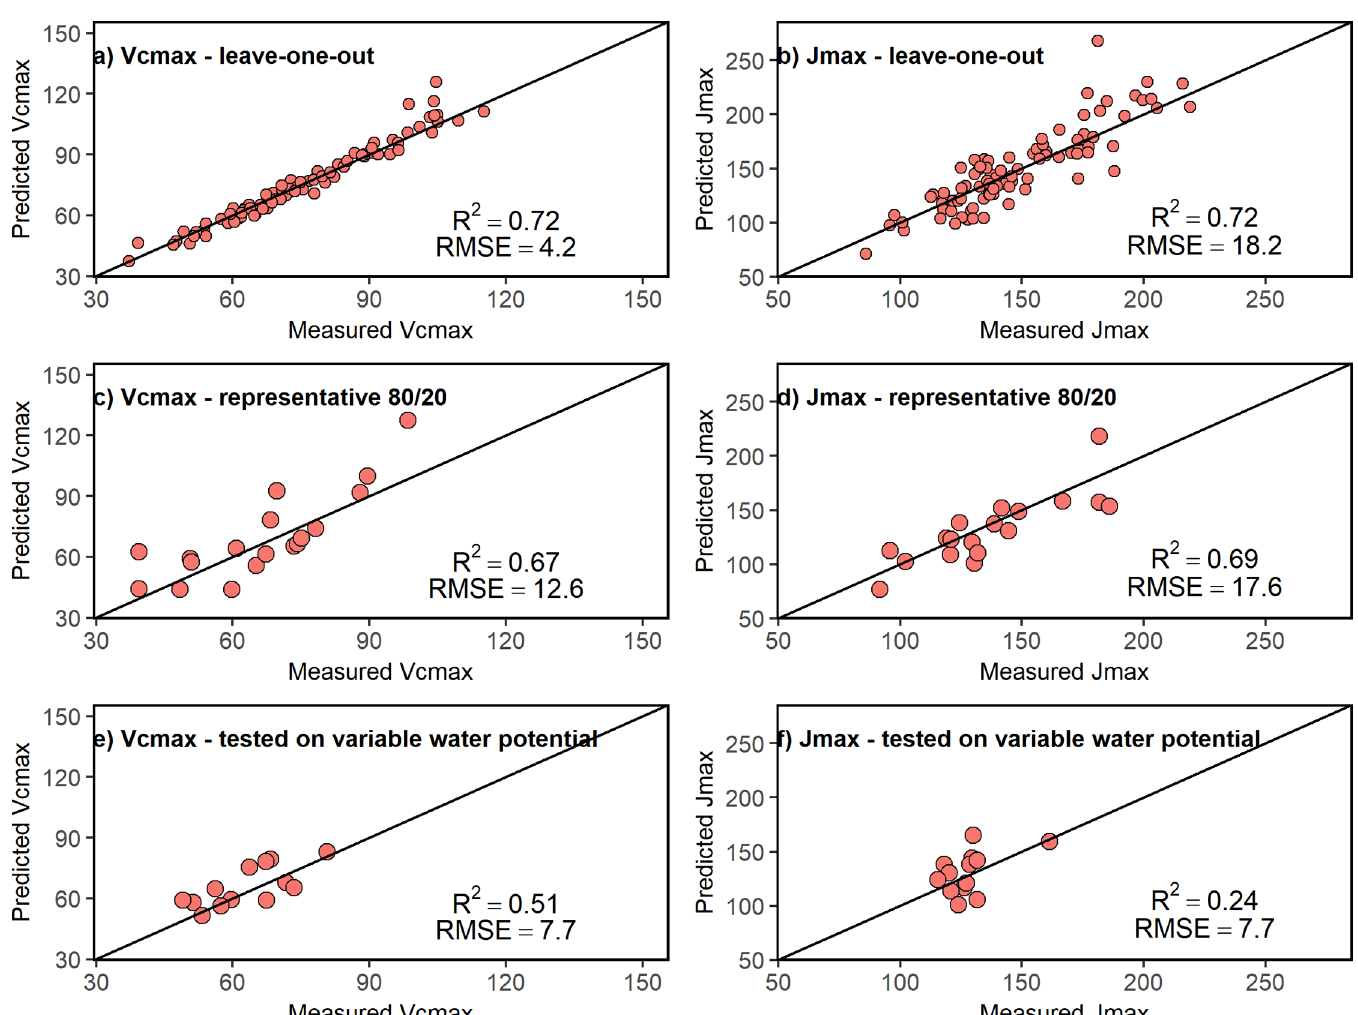
Fig 3. Temporal stability of PLSR models. All figures show observedvs. predictedvalues from PLS regression models. A&B: leave-one-out cross- validation procedurefor (a) maximum rates of RuBP carboxylation (V cmax , μ mol m -2 s- 1 ) and (b) RuBP regeneration J max ( μ mol m -2 s- 1 ), n = 86. C&D: representative 80/20%split of the data for PLSR (C) V cmax ( μ mol m -2 s- 1 ) and (D) J max ( μ mol m -2 s- 1 ). Each model was trained on 69 observations and tested on 17 observations. E & F: models tested on the periodwith the greatest between-individualvariation in pre-dawnwater potential( Ψ pd ) for (E) V cmax ( μ molm -2 s- 1 ) and (F) J max ( μ molm -2 s- 1 ). Each model was trained on 74 observations and tested on the 12 observations on 6/23/2016 and 6/24/2016when the populationvaried widely in Ψ pd . Statistical tests of increasein rigor moving